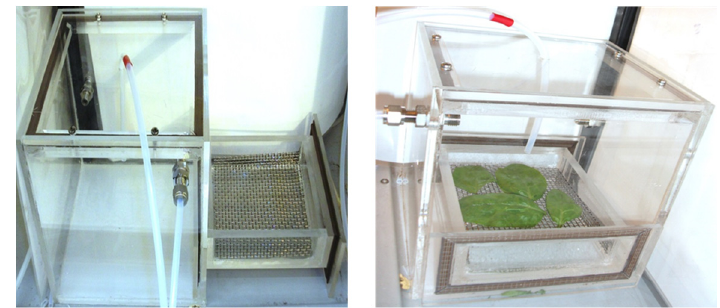
Figure 10. Modified ozone fumigation